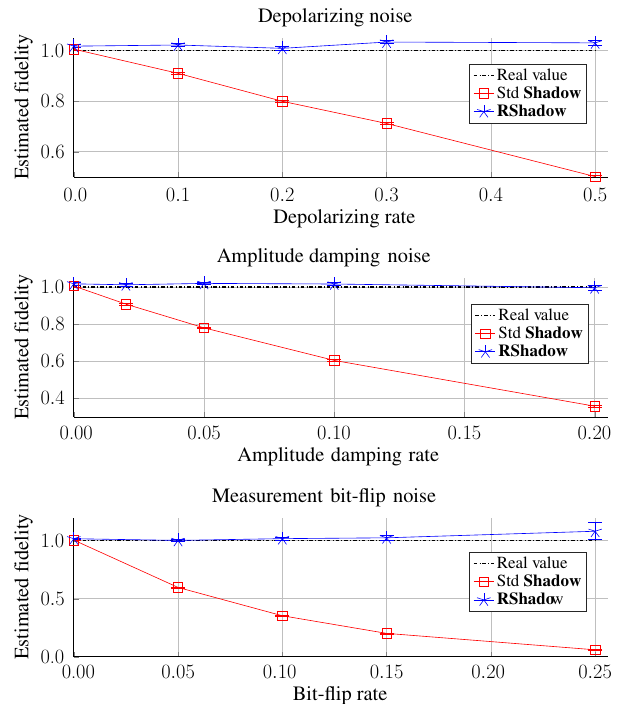
FIG. 2. Comparison of the GHZ-state fidelity estimation using standard Shadow and RShadow with respect to different noise models and noise levels. The black dashed line represents the true value. The red crosses and the blue stars represent the estimated values of standard Shadow and RShadow , respectively.